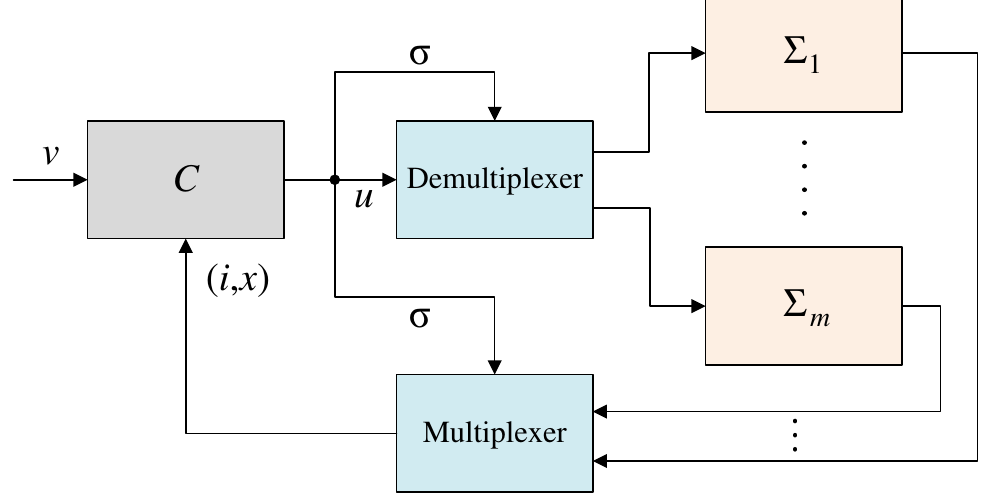
Figure 3. Corrective control system for the switched